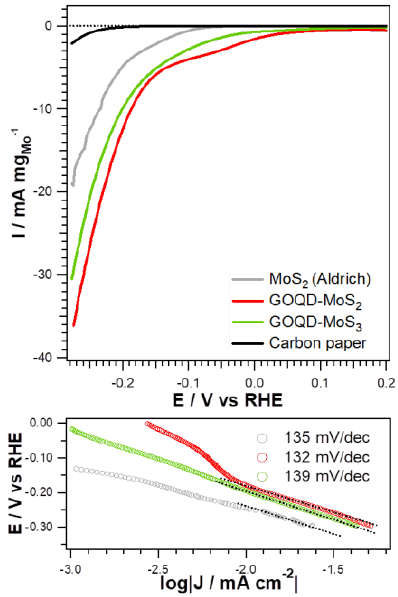
Figure 2. Polarization curves (not IR corrected, upper panel) and corresponding Tafel plots (bottom panel) in deaerated 0.5 M H 2 SO 4 for the GOQD-MoS x (x = 2 and 3) and commercial MoS 2 modified electrodes acquired at room temperature and at a scan rate of 5 mV s −1 .